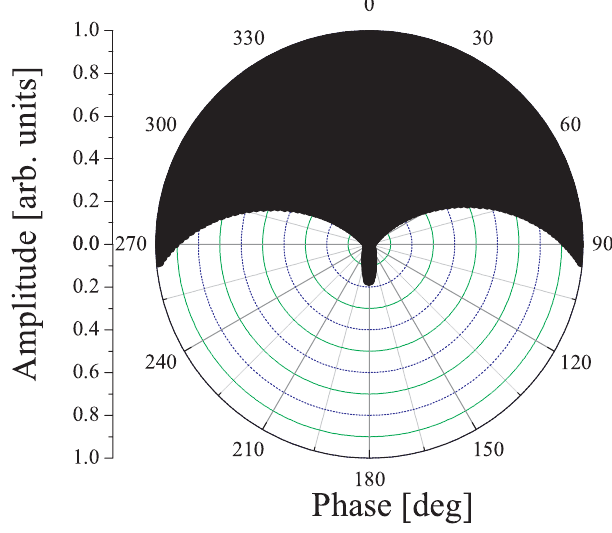
FIG. 3. (Color) Controllable range of the phase and amplitude of the (cid:1)(cid:2) - A